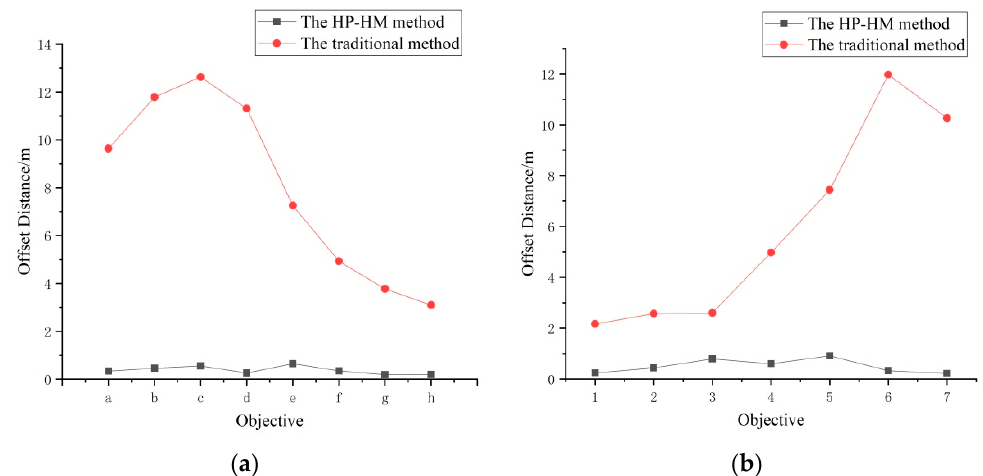
Figure 11. The object mapping deviation of different homography matrices in the office: ( a ) Camera 1 and ( b ) Camera 2.